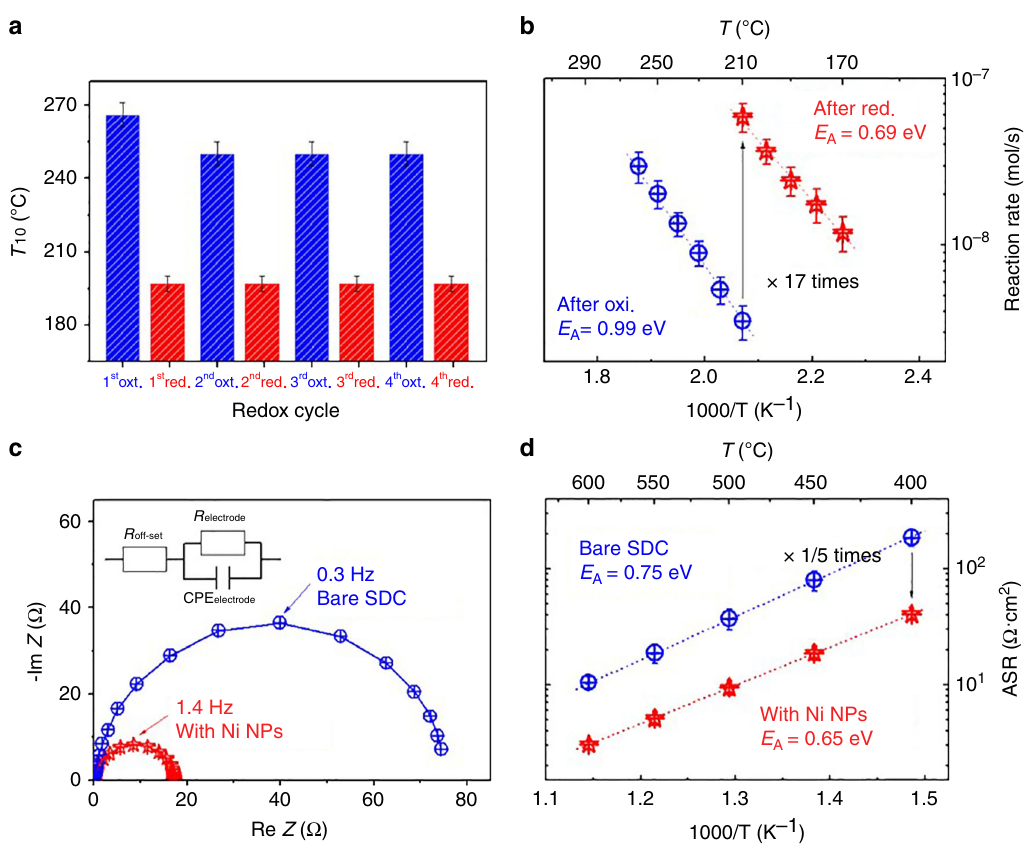
Fig. 6 Chemical and electrochemical reactivity of Ni nanoparticles. a The temperatures at which 10% conversion of CO to CO 2 occurs on nanoporous CeO 2 thin fi lms according to redox cycles at 700°C. The combustion of CO via oxidation was measured at 250°C, and the grain boundaries of ceria were heterogeneously doped with Pt. b Kinetic rate data for CO oxidation on the ceria thin fi lms after oxidation/reduction at 700°C. c Typical impedance spectra of SDC symmetric cells with fi tting results denoted by the solid line at 60°C (the ohmic resistance was removed for ease of the comparison of the electrode resistance). d A comparison of the temperature dependence of the electrode resistance for the H 2 electro-oxidation reaction after